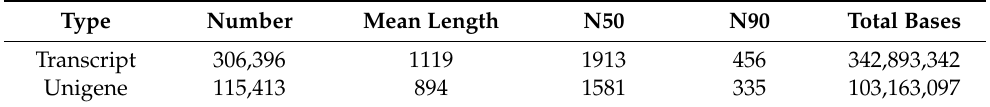
Figure 3. Assembly and annotation of the transcriptome from the pulp of Feizixiao lychee: ( a ) se- quence length distribution; ( b ) statistical chart of species with gene homology; ( c ) statistical chart of KOG function classification. Table 2. The statistics of assembly results.